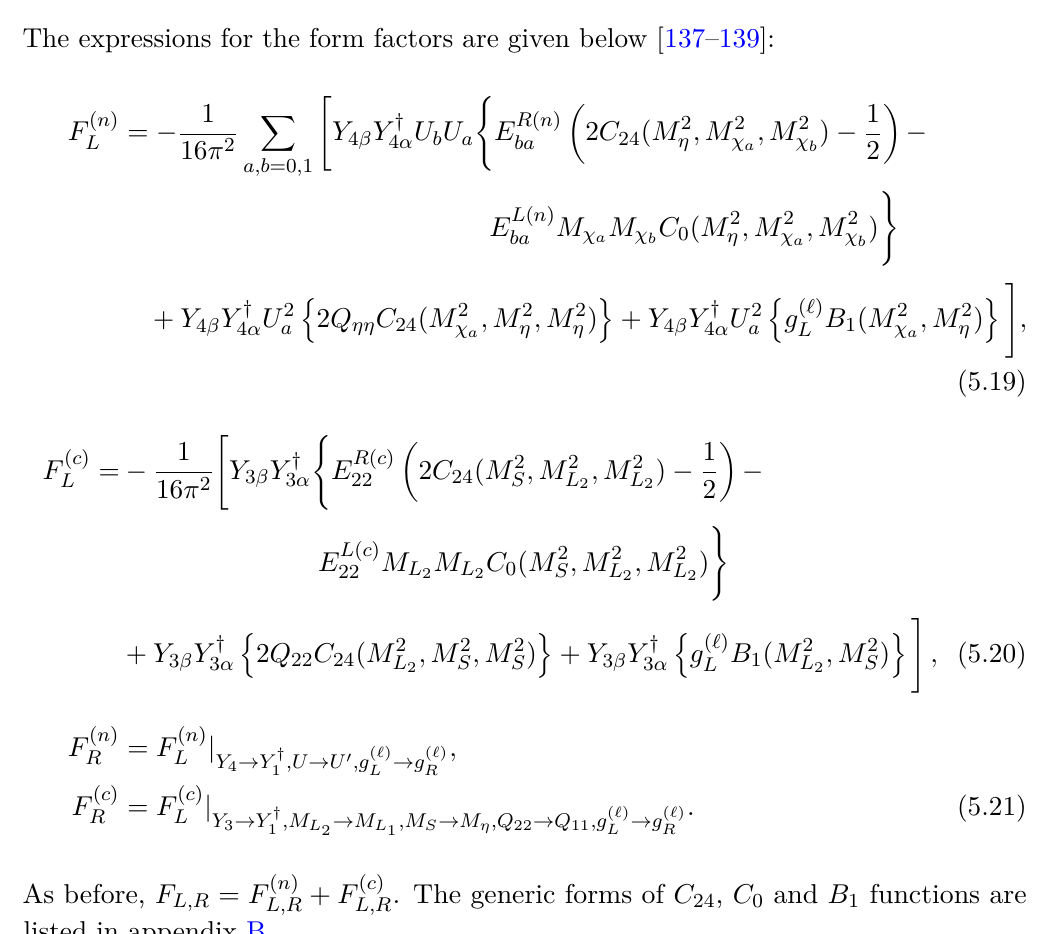
Figure 7 . Leading Z penguin diagrams contributing to the ‘ − are also considered (not shown). Indices a, b = 1 , 2 (for L ± as